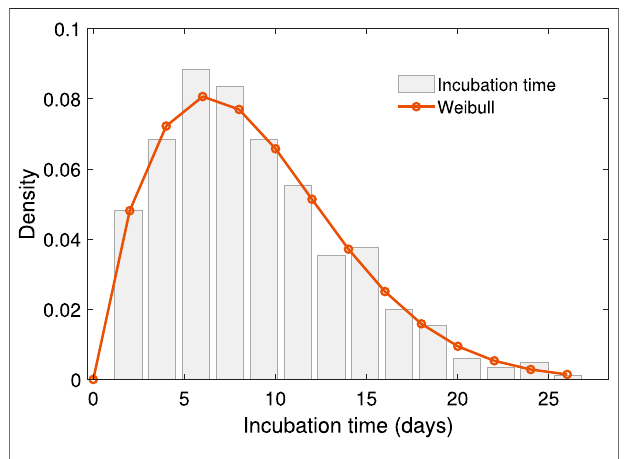
FIGURE 1 | The empirical distribution and Weibull distribution fi tting of incubation time. The Weibull distribution has density function f W ( x ; A , B ) (cid:1) k − 1 k λ (cid:4) x λ (cid:5) e −( x / λ ) k , x ≥ 0 with λ (cid:1) 9 . 93, and k (cid:1) 1 . 79. The K – S test is 0.17, which means that Weibull distribution is proper for the data.